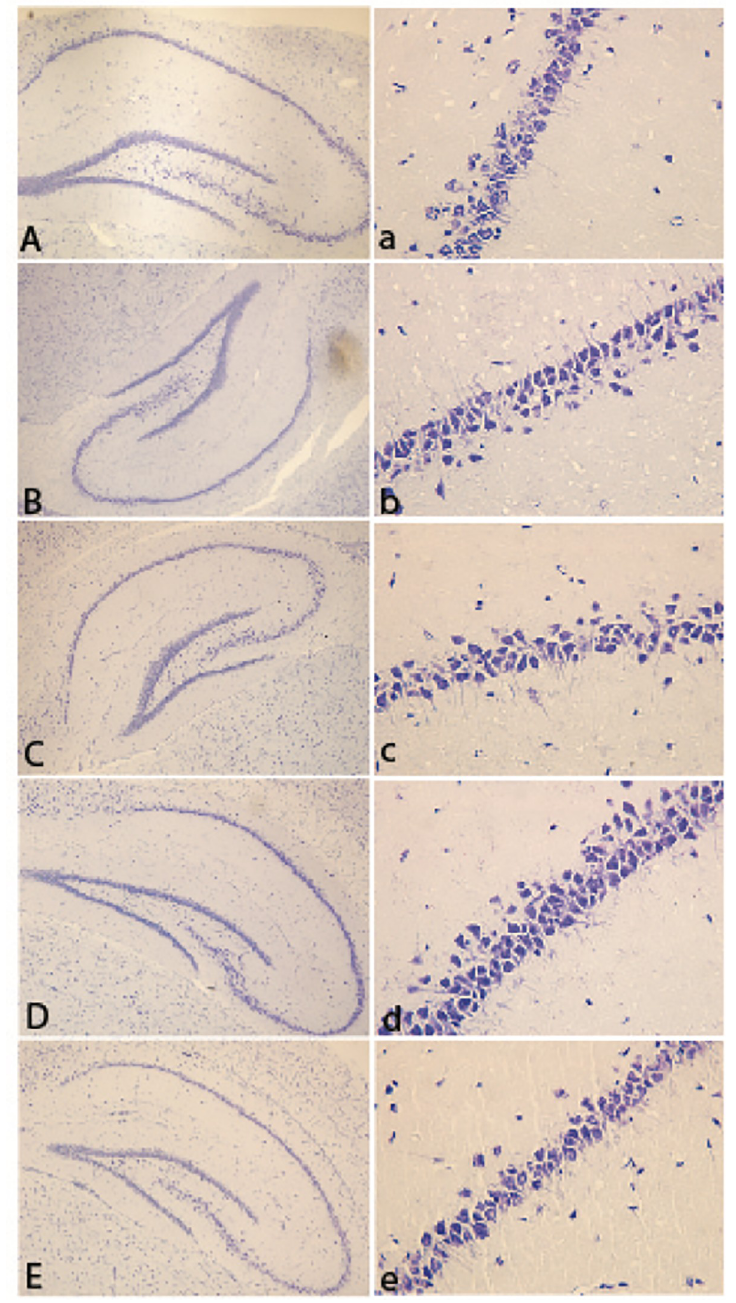
Fig 2. Histological examination of the hippocampal region using Cresyl violet staining. The effects of environmental paradigm and pharmacological intervention on hippocampal neurons were measured using Cresyl violet staining. Representative micrographs of the CA1 and the hippocampus. The first column of micrographs was captured at Low magnification under a light microscope; the remaining micrographs were captured at higher magnification under a light microscope. (A, a) representative images of the hippocampus region in the control group (B, b) isolated, (C, c) flux treated, (D, d) etanercept treated, and (E, e) the EE condition.